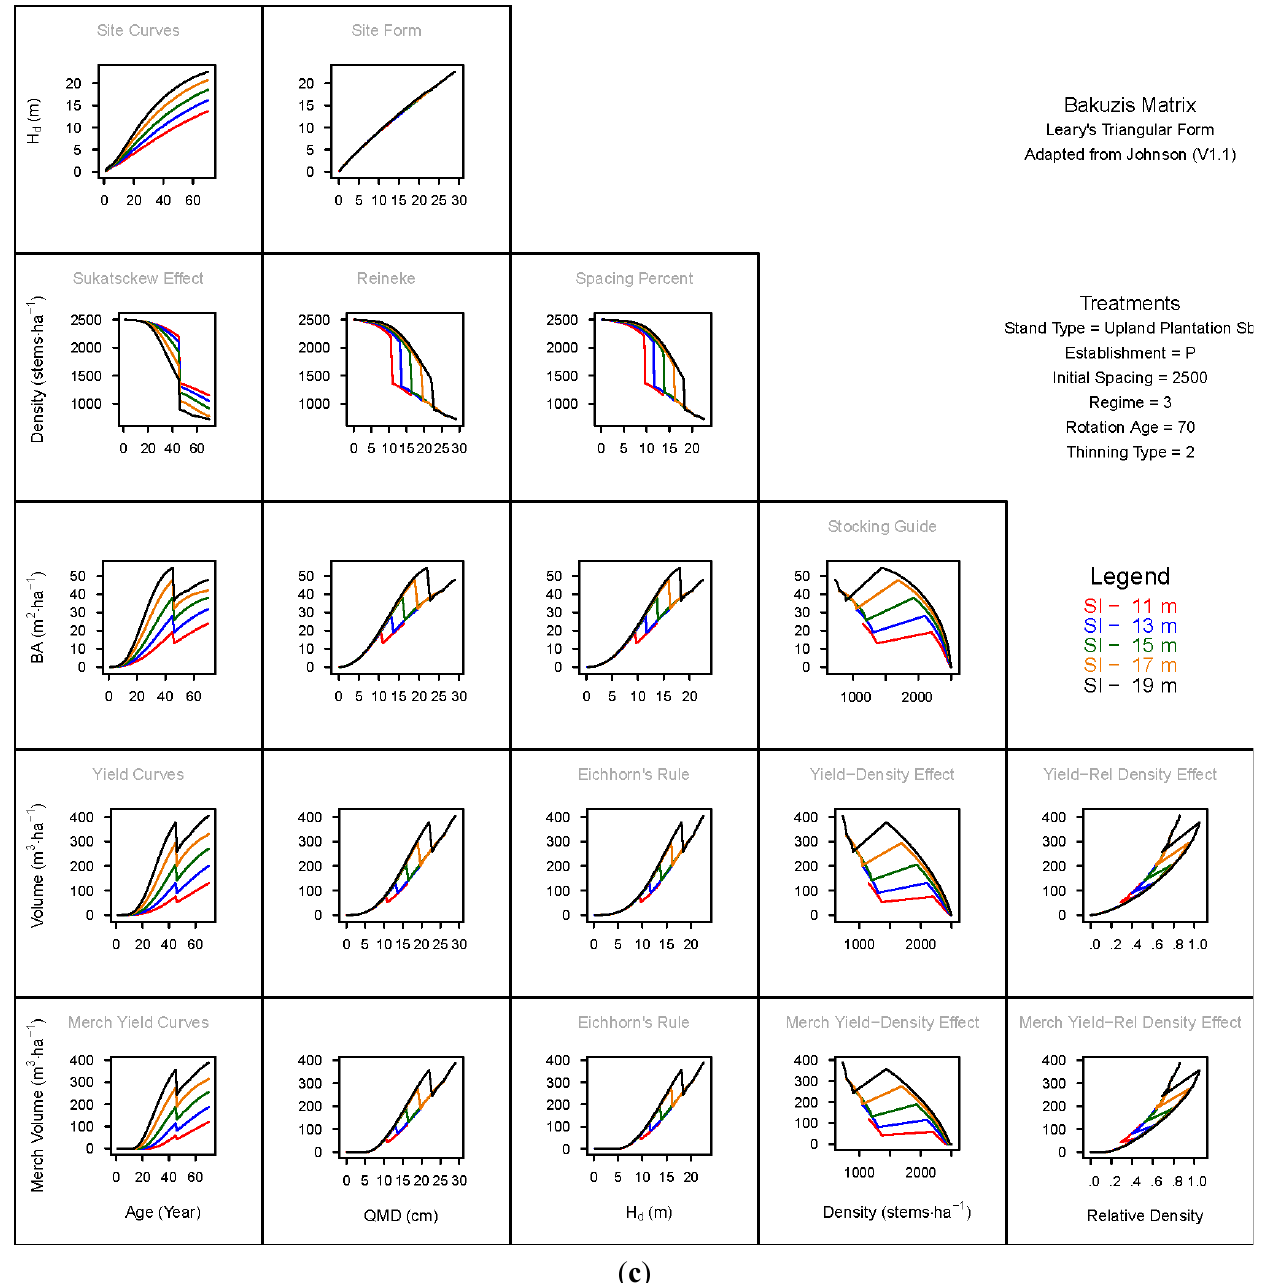
Figure A1. Bakuzis matrices for genetically-improved unthinned and commercially thinned (CT) upland black spruce (Sb) plantations (P) which were established at an initial densities of 2500 stems/ha and grown on 5 site qualities (SI) over 70 year rotations: ( a ) Regime 1 represented unthinned plantations in which genetic worth effects were described by the Type 1 response model; ( b ) Regime 2 was initially identical to Regime 1 and employed the same response model, however, the plantations were subjected to a single CT treatment at a stand age of 45 years in which the basal areas were reduced by 35%; and ( c ) Regime 3 was identical to Regime 2 but used the Type 2 response model to account for genetic worth